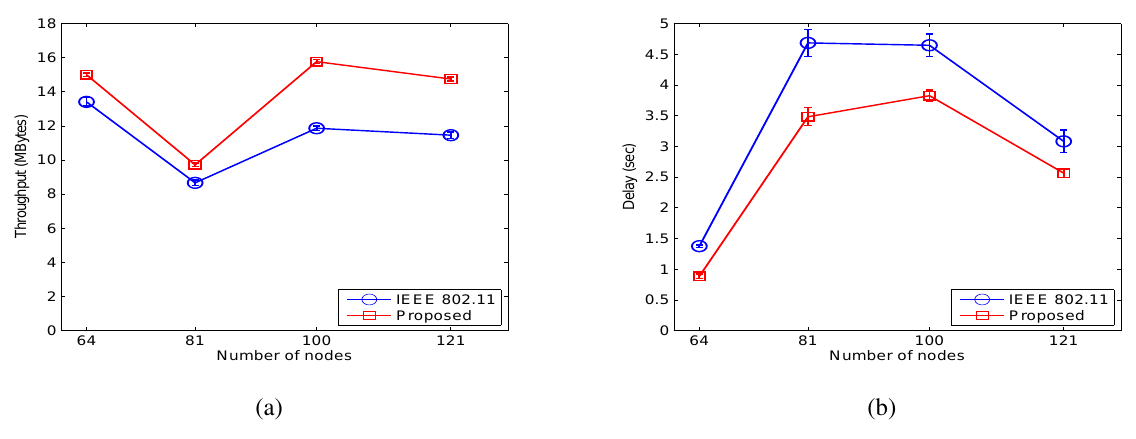
Figure 12. Simulation results for random networks when σ (b)